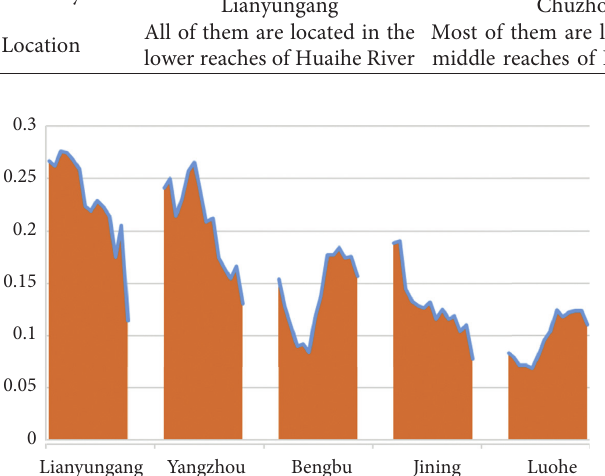
Figure 1: Comparison of economic vitality and competitiveness of some cities over the